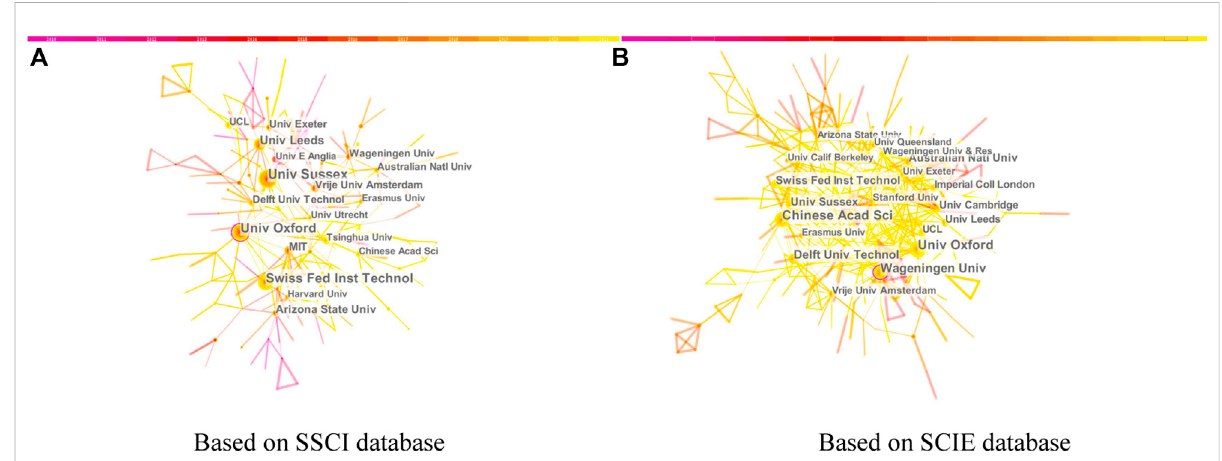
FIGURE 2 Map of the institution co-authorship network of climate innovation research. (A) refers to the SSCI database and (B) refers to the SCI database.